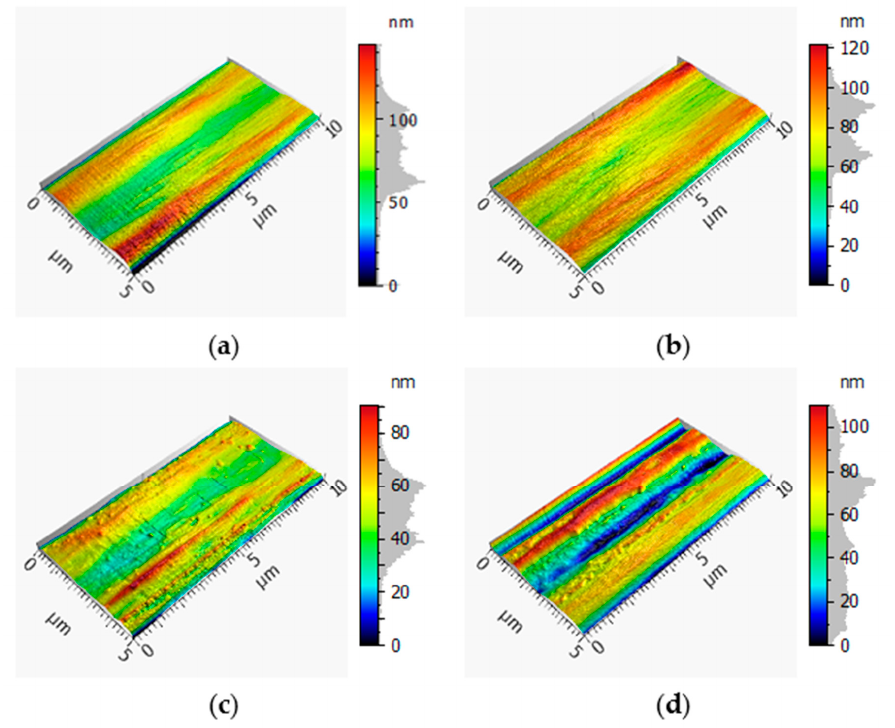
Figure 2. 3D, 5 µ m × 10 µ m surface profile of ( a ) the reference fiber, ( b ) the reference without the sizing agent, ( c ) a fiber detached with a power output of 66% and ( d ) a fiber detached from the treated sample with a power output of 96%.